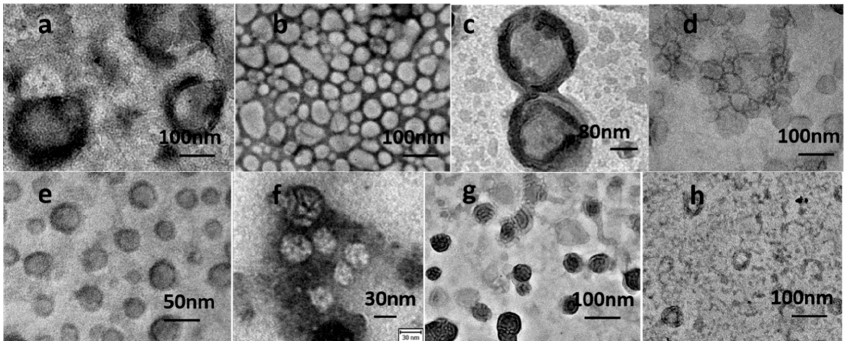
Figure 1. Field emission transmission electron microscope (FETEM) images of polymeric vesicles from di ff erent polymers. ( a ) Vesicles from ABANH 2 triblock copolymers with amine ending group, ( b ) cesicles from ABAM triblock copolymers with meth acrylate ending group, ( c ) vesicles from ABAOH triblock copolymers with hydroxyl ending group, ( d ) vesicles from ABACOOH triblock copolymers with carboxyl group, ( e ) vesicles from PPO- b -PEO diblock copolymers, ( f ) vesicles from PBD- b -PEO diblock copolymers, ( g ) vesicles from PDMS- b -PEO, ( h ) vesicles from PS- b -PEO diblock copolymers.